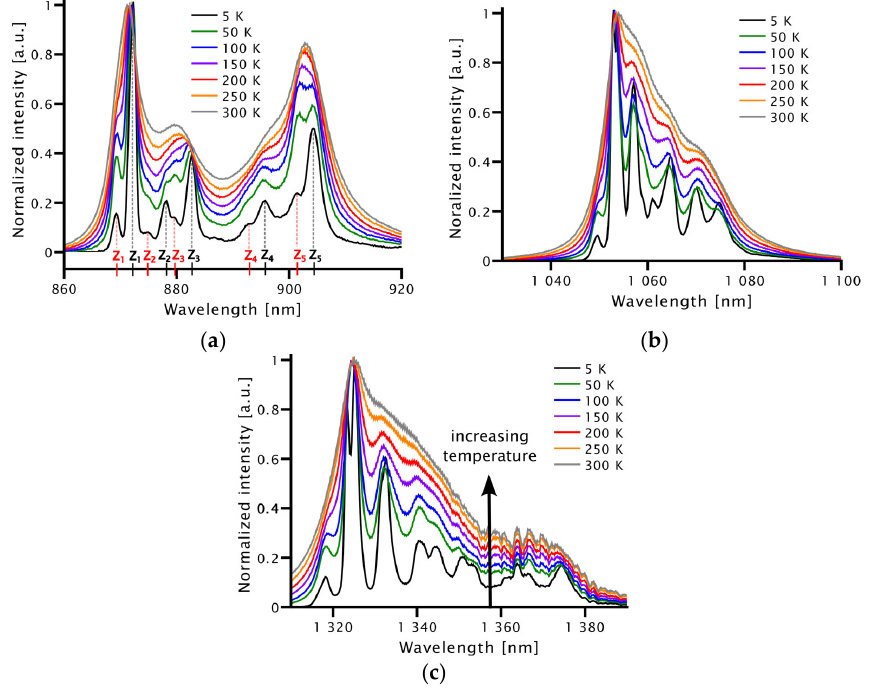
Figure 5. Temperature-dependent emission spectra of amorphous bulk material of [Nd( L2 ) 3 (NO 3 ) 3 ] ( 3 ) assigned to 4 F 3/2 → 4 I 9/2 ( a ), 4 F 3/2 → 4 I 11/2 ( b ), and 4 F 3/2 → 4 I 13/2 ( c ) transitions, respectively. For the 4 F 3/2 → 4 I 9/2 transition the emission lines are labeled: Transition lines from R 1 are marked in black (Z 1 -Z 5 ) and from R 2 to Z 1 -Z 5 in red. The spiky signal of the 4 F 3/2 → 4 I 13/2 transition in ( c ) between 1350 nm and 1380 nm is related to setup noise.